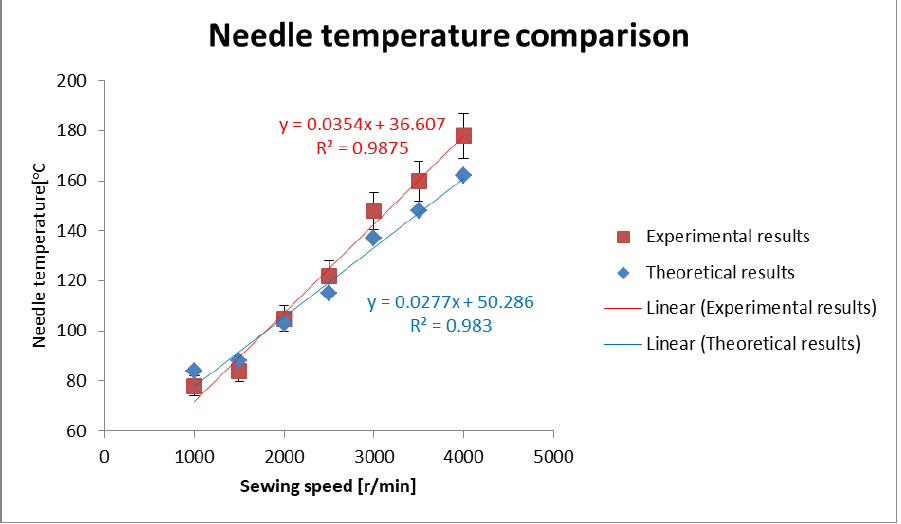
Figure 5. Comparison of experimental and theoretical results.